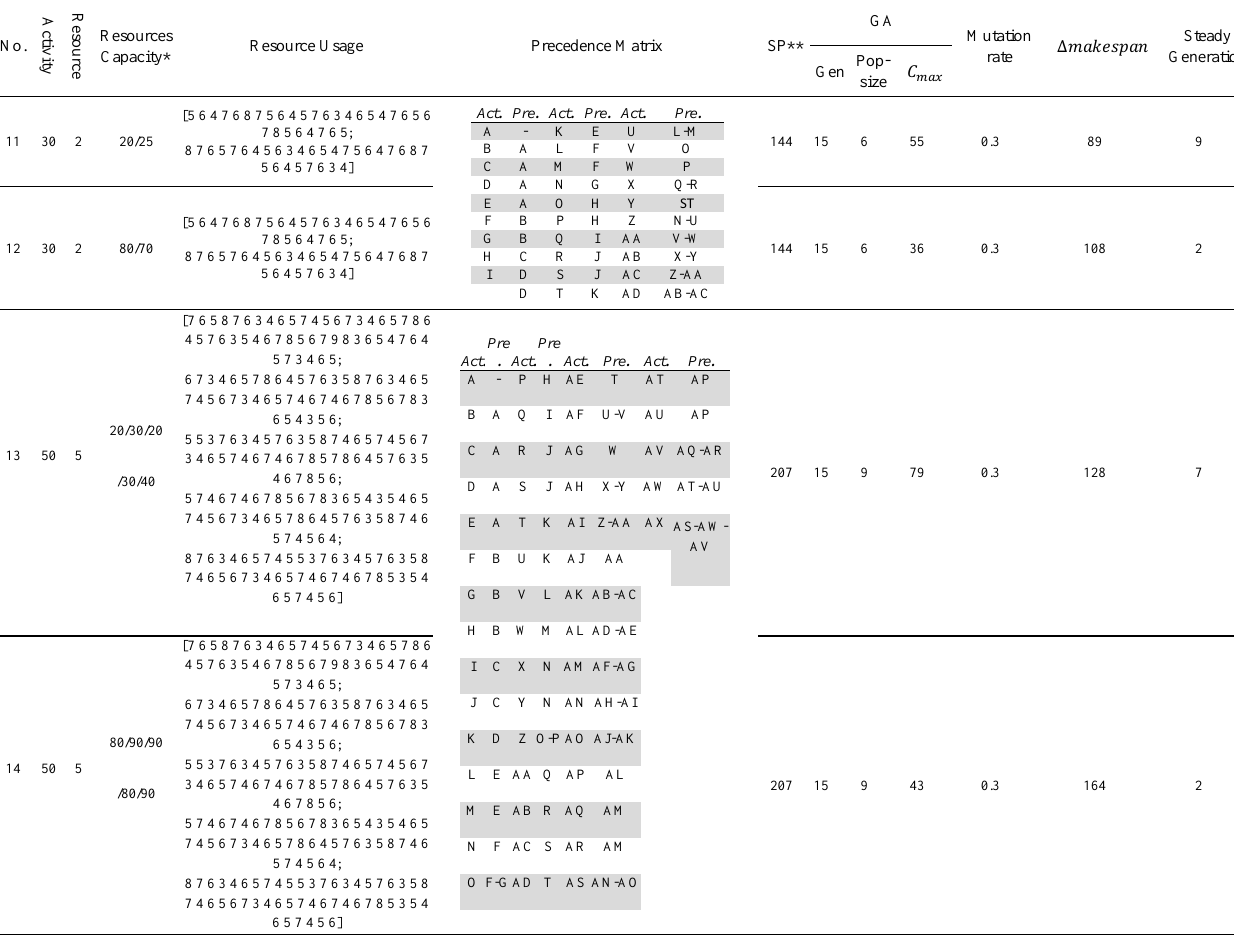
Numerical Examples for the Proposed Backward-forward Method (Continued from table 5) A c ti No. v it